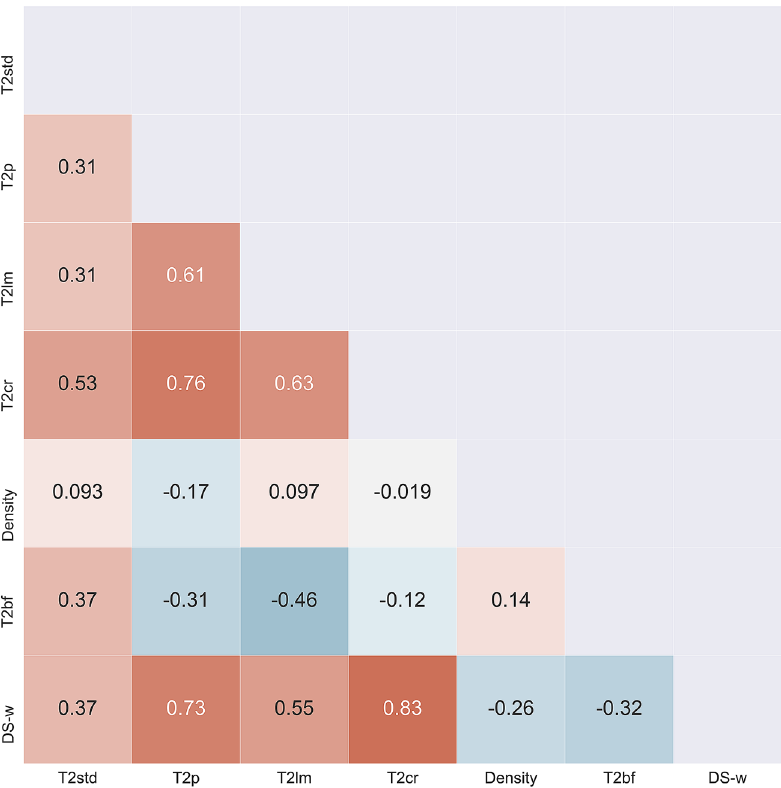
Figure 5. The diagonal correlation matrix showing the amount of linear dependence between six input features with Dean-Stark water content (DS-w). Scores represent the Pearson’s correlation coefficient and are color coded (heatmap).